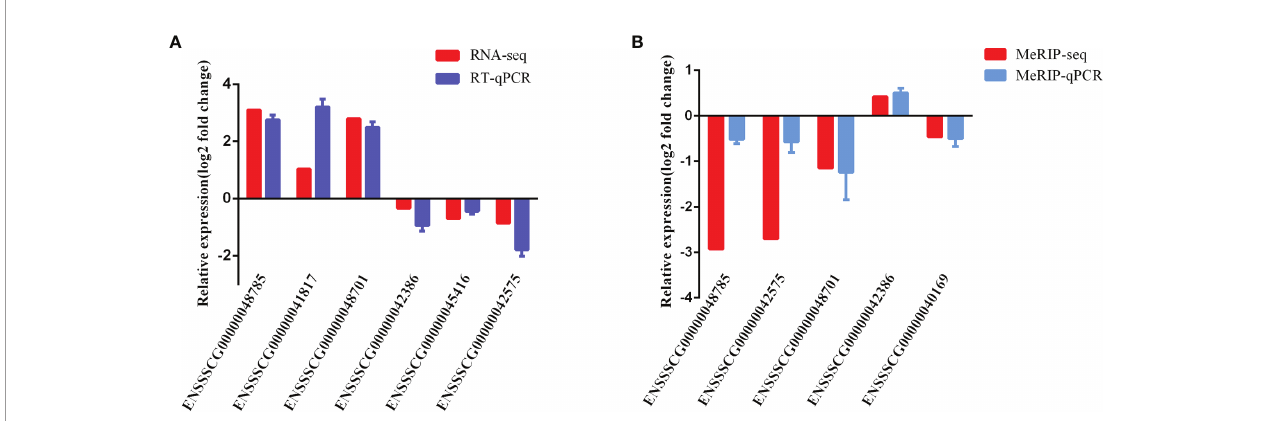
FIGURE 8 | Validation of MeRIP-seq and RNA-seq by qRT-PCR and MeRIP-qPCR. (A) RT-qPCR validation of six lncRNAs. (B) MeRIP-qPCR validation of fi ve m6A- modi fi